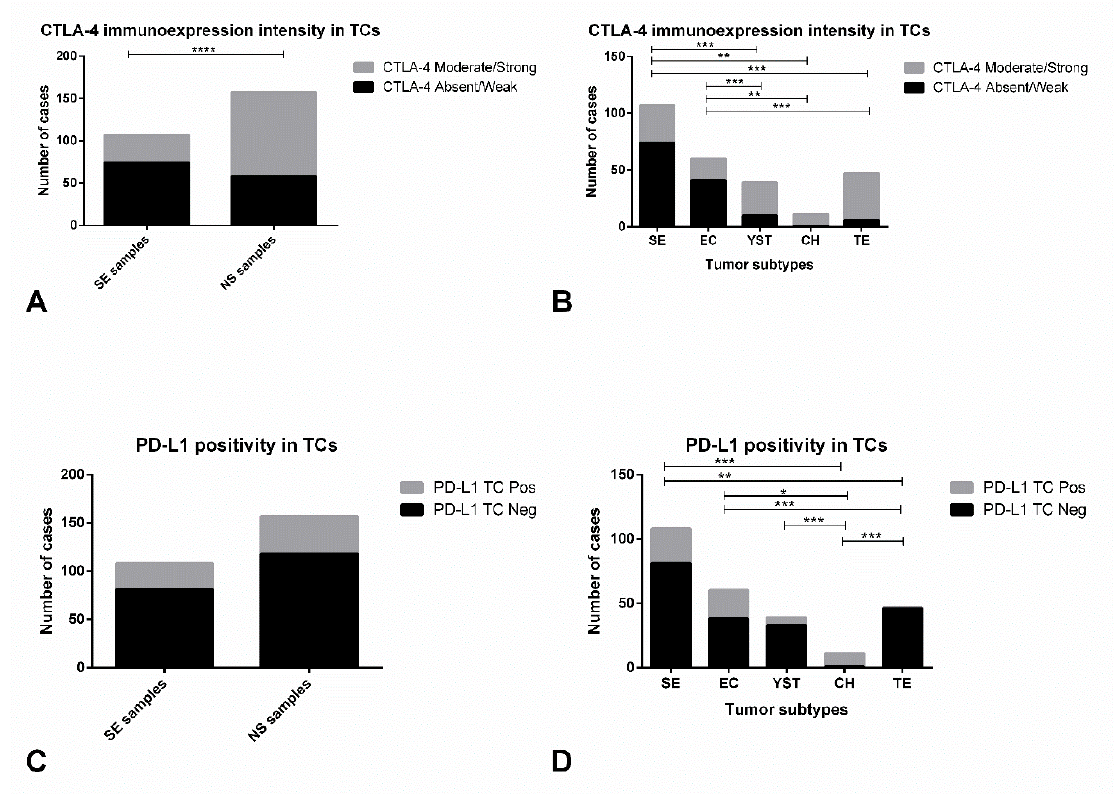
Figure 5. Immunoexpression of CTLA-4 and PD-L1 in tumor cells of testicular germ cell tumor subtypes. CTLA-4 immunoexpression intensity in tumor cells among seminomas and non-seminomas